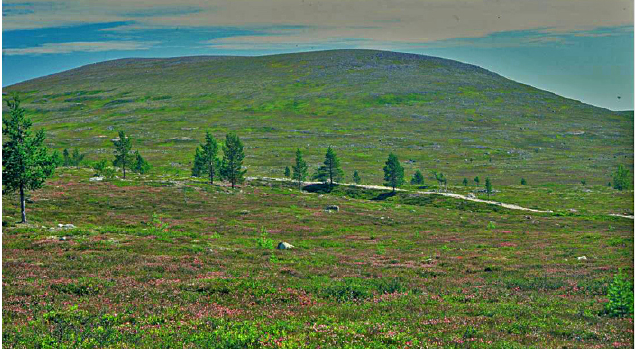
Figure 28: A sparse belt of pine is evolving atop of the sub- alpine birch forest belt. Mt. Barfredhågna. 14 July 2003.